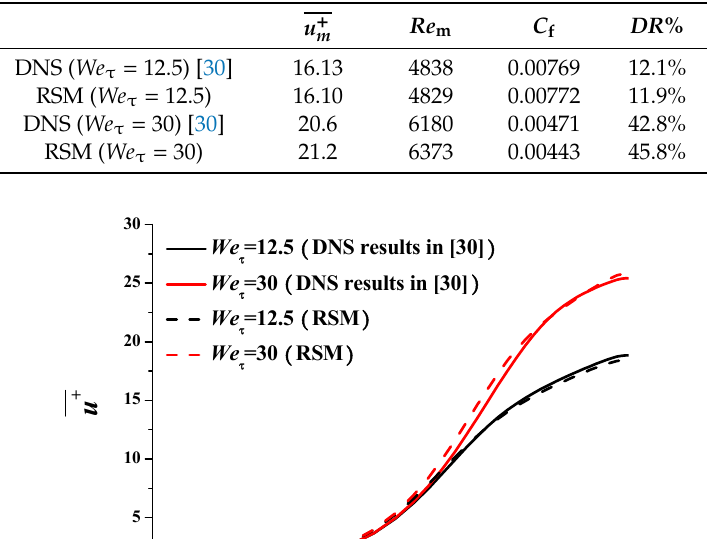
Figure 5. Mean conformation tensor.